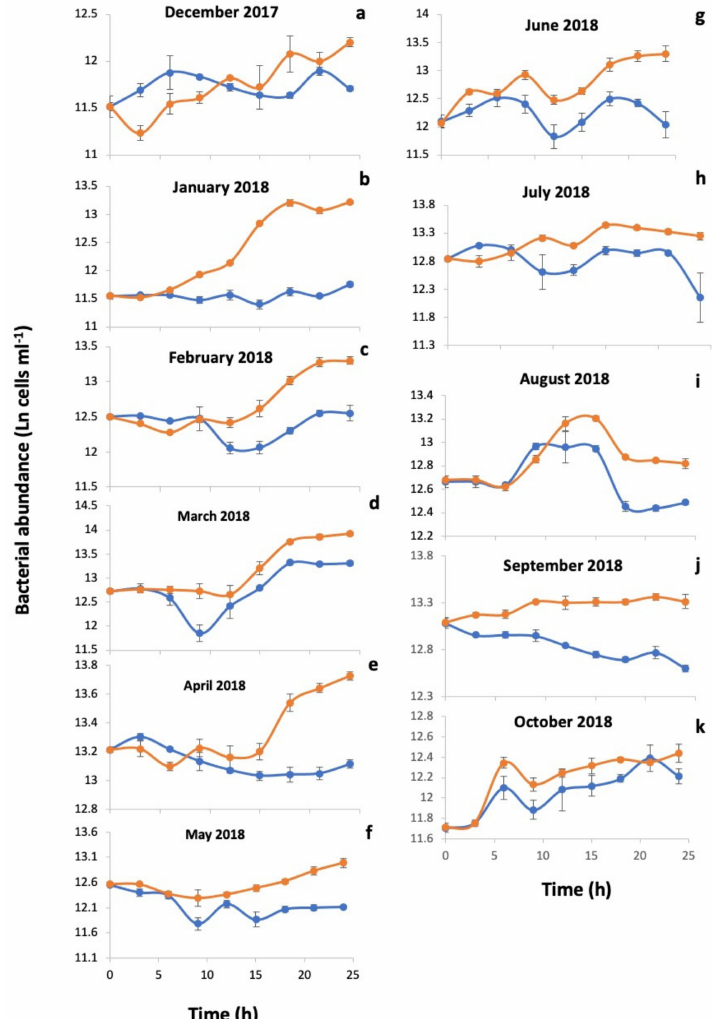
Figure 4. Changes in heterotrophic bacterial abundance with time in incubations treated with mitomycin C and in untreated controls. The plots ( a – k ) represent different months of induction. Blue lines and dots correspond to samples treated with mitomycin C (1 µ g mL − 1 ), while orange lines and dots correspond to the untreated controls. Error bars are standard errors of three replicates for each incubation